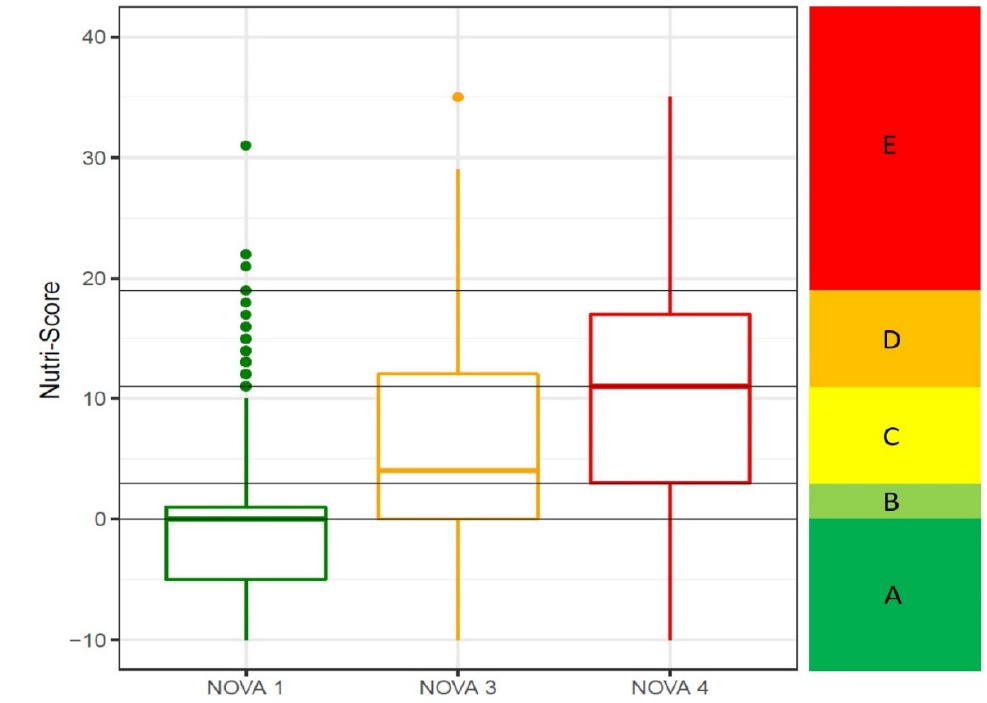
Figure 4. Boxplot showing the Nutri-Score values according to the different food processing cate- gories (NOVA classification). NOVA 2 is not shown as it only represented 1% of the data. The box boundaries represent the interquartile range (IQR) and the line inside the box shows the median value. The black horizontal lines represent the score boundaries of each of the Nutri-Score catego- ries.